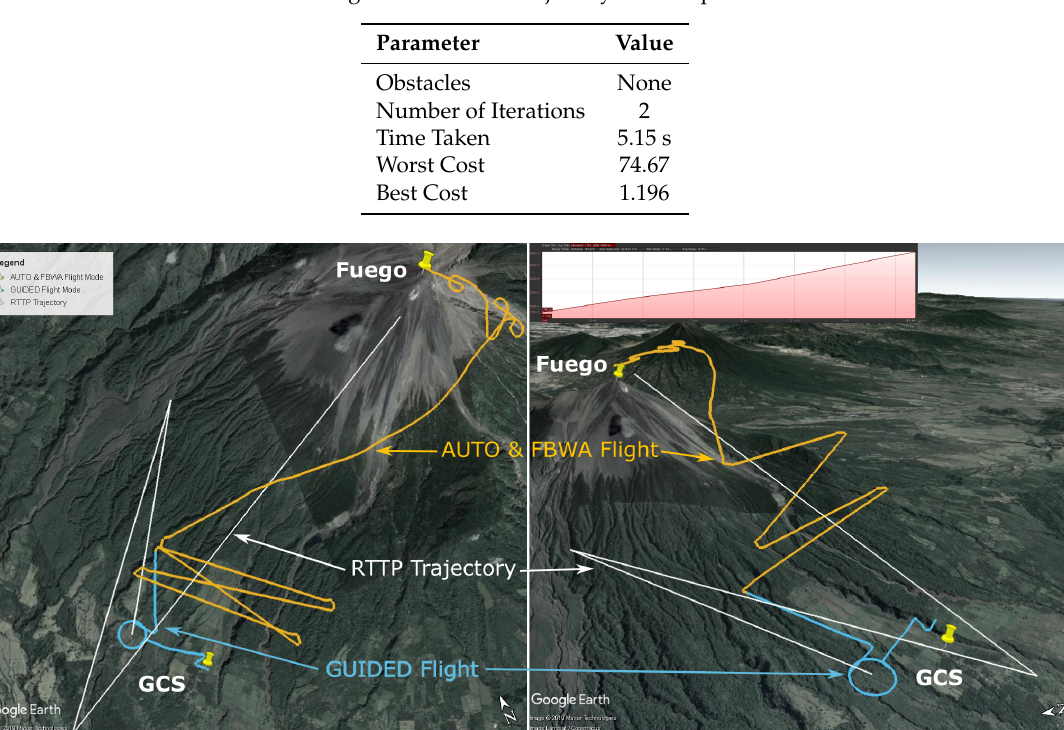
Table 2. Flight A Real Time Trajectory Planner parameters.